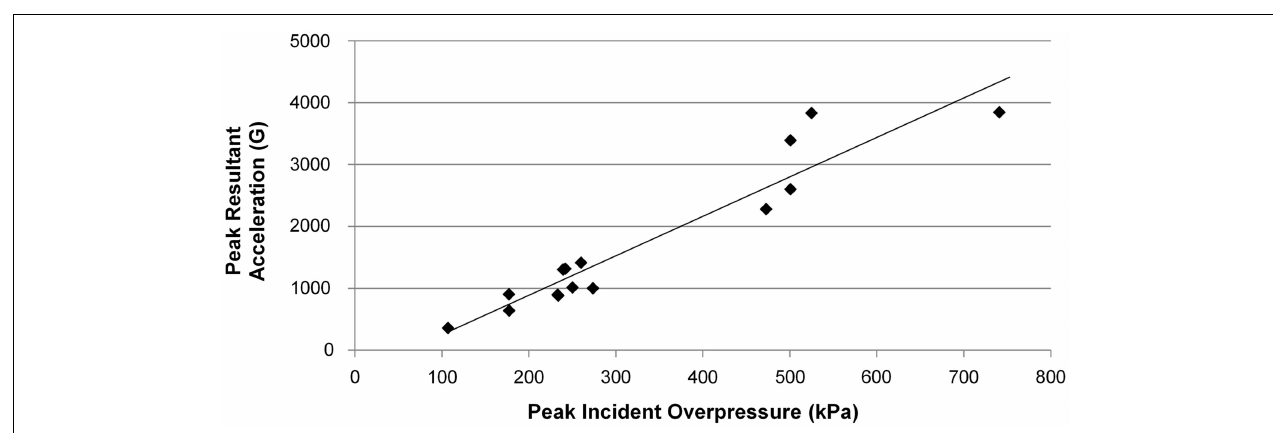
FIGURE 11 | Linear model for peak head resultant acceleration vs. peak incident overpressure ( R 2 = 0.904 and p < 0.0001).